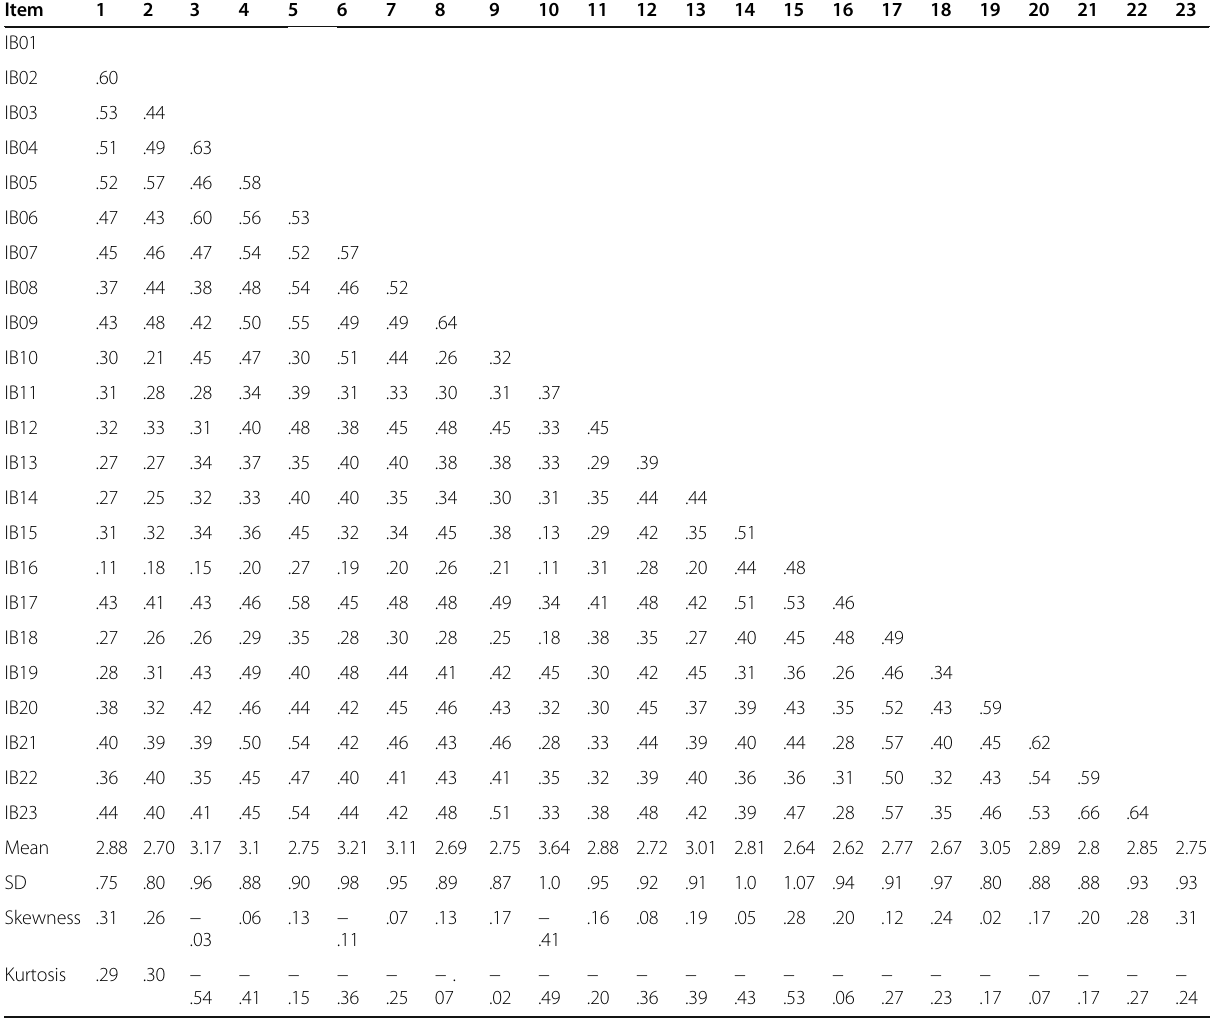
Table 2 Mean, standard deviation, skewness, kurtosis, and intercorrelation between all items ( N = 508)